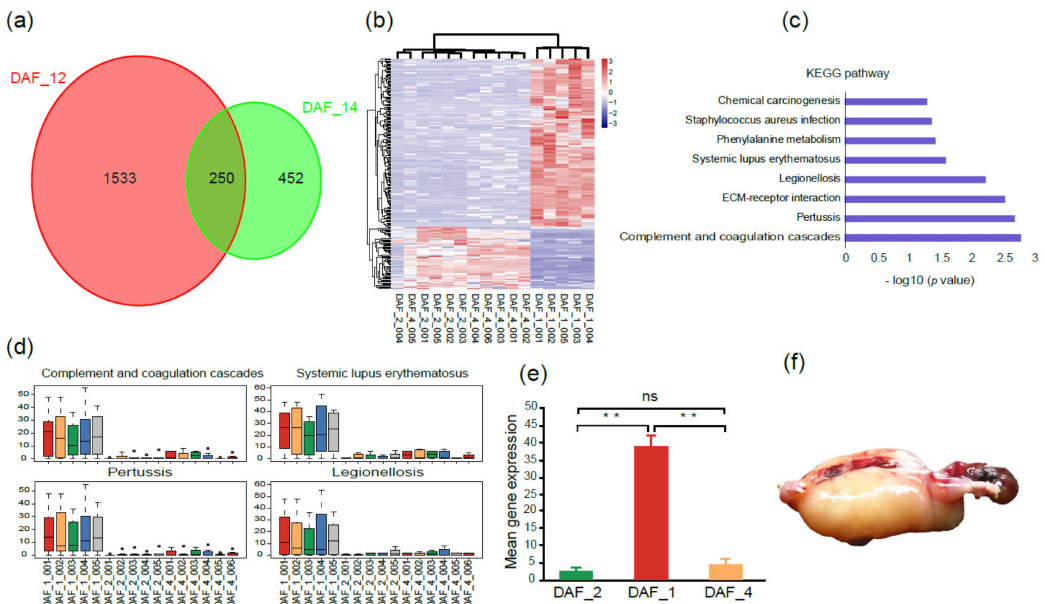
Figure 3. Gene expression patterns and KEGG analysis between abnormal and normal fetuses. ( a ) Venn diagram shows the overlapped DEGs between DAF_1 and DAF_2 and between DAF_1 and DAF_4. ( b ) Heatmap of overlapped DEGs between abnormal and normal fetuses; the pink color represents a higher expression level, and the blue color represents a lower expression level. ( c ) KEGG enriched pathways of overlapped DEGs. ( d ) Comparison of gene expression levels of the genes within four disease and pathogen-associated pathways between abnormal and normal fetuses. ( e ) Genes related to pathogen and disease infections had significantly higher expression levels in DAF_1 than in DAF_2 or DAF_4 ( t -test, ** p < 0.01, ns p > 0.05). ( f ) The abnormal fetus DAF_1 had a typical edema